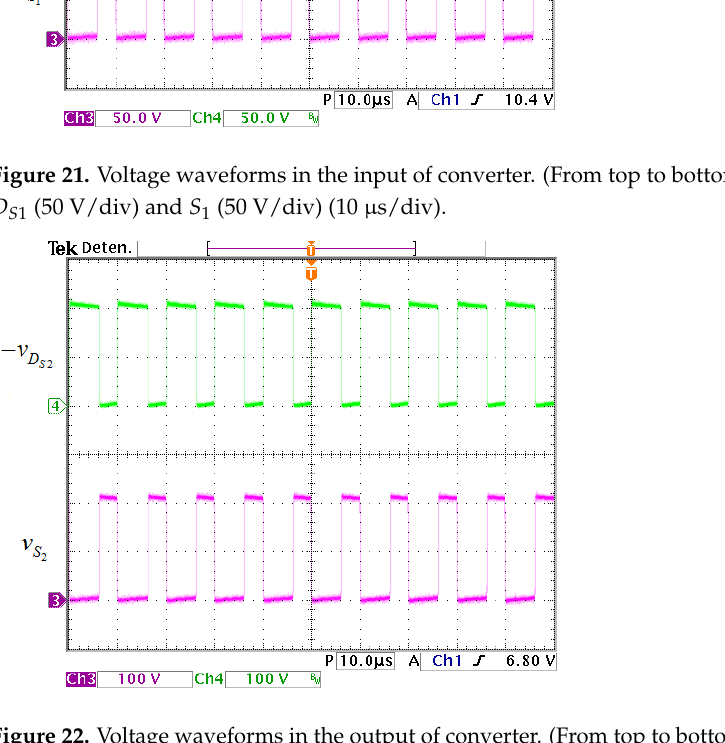
Figure 22. Voltage waveforms in the output of converter. (From top to bottom) Voltage waveforms in